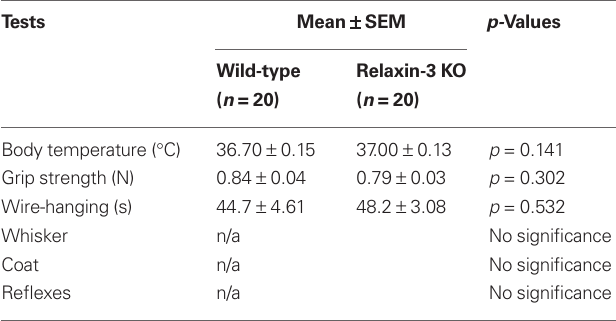
Table 1 | general health of relaxin-3 KO